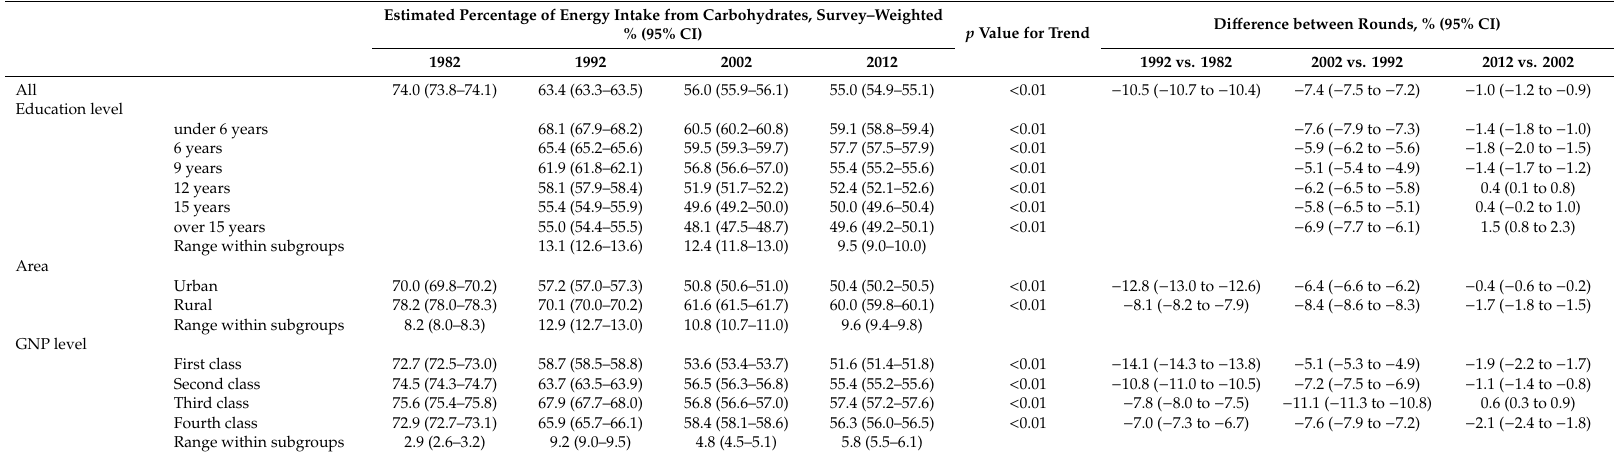
Table 4. Trends and Disparities in the Estimated Percentage of Energy Intake from Carbohydrates of Adults Aged 18 Years or Older by CNNS Round, 1982–2012 1